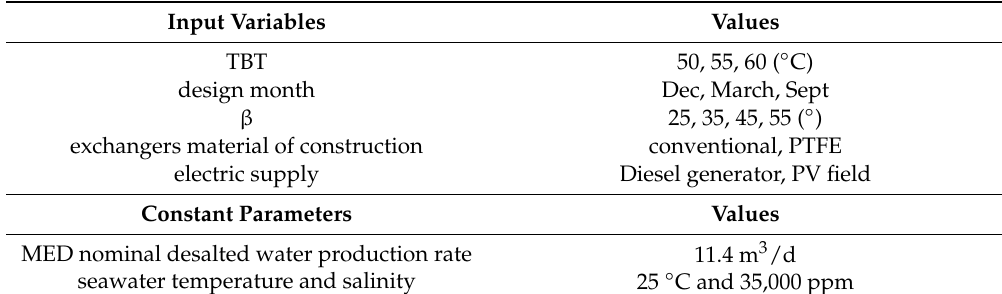
Table 1. Main variables and parameters of the